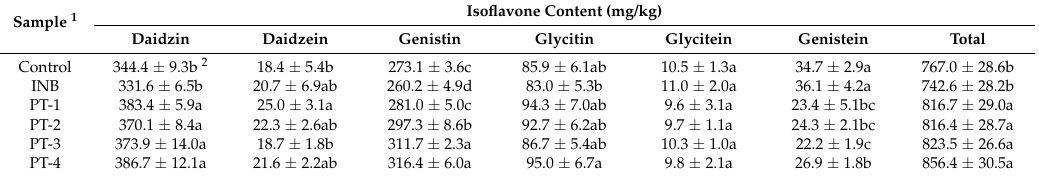
1 Samples are defined in Table 1. 2 Values are expressed as mean ± standard deviation of three replicates. Values followed by different letters (a, b, c, and d) in the same column are significantly different ( p < 0.05, ANOVA, Tukey